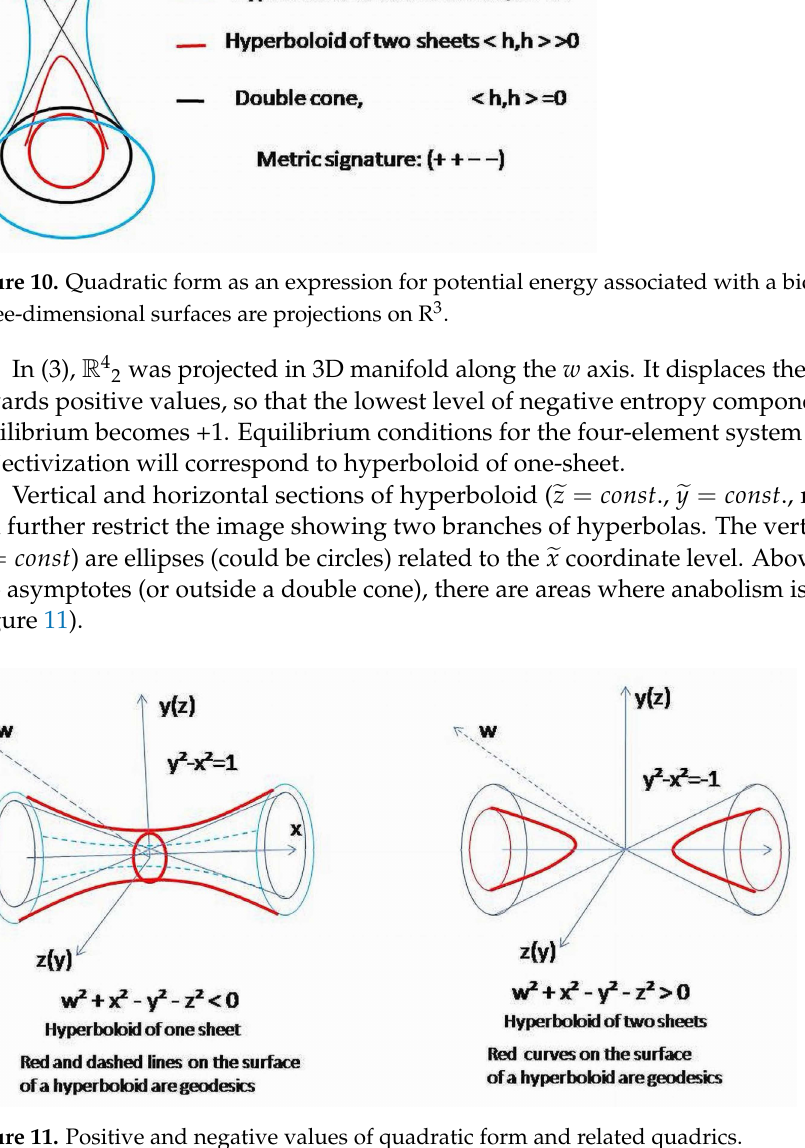
Figure 11. Positive and negative values of quadratic form and related